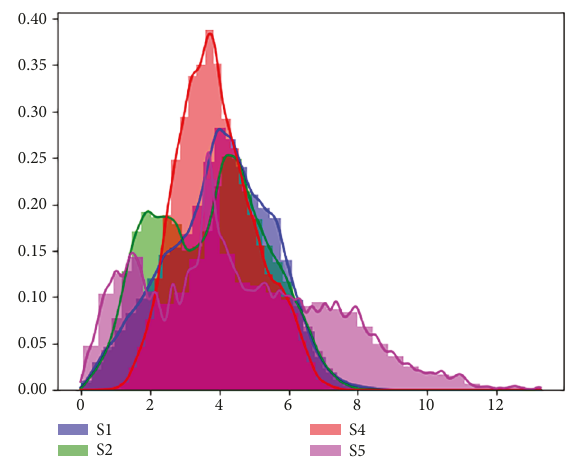
Figure 8: Map of relative difference of wind speed over D2 between S2 and S3 during the simulation period.